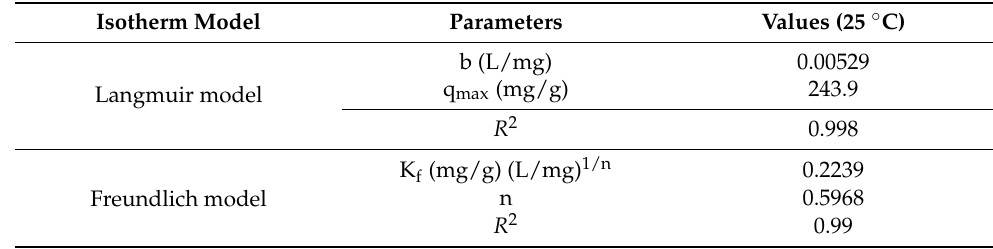
Table 2. Adsorption isotherm parameters of the oil adsorption into the beads. Isotherm Model